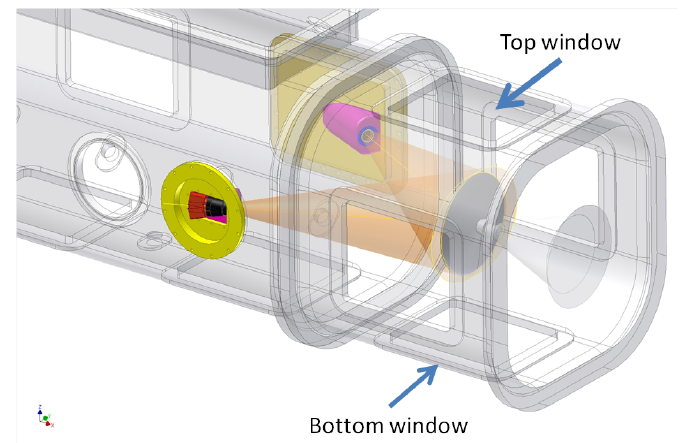
Figure 14. Proposed camera set-up.